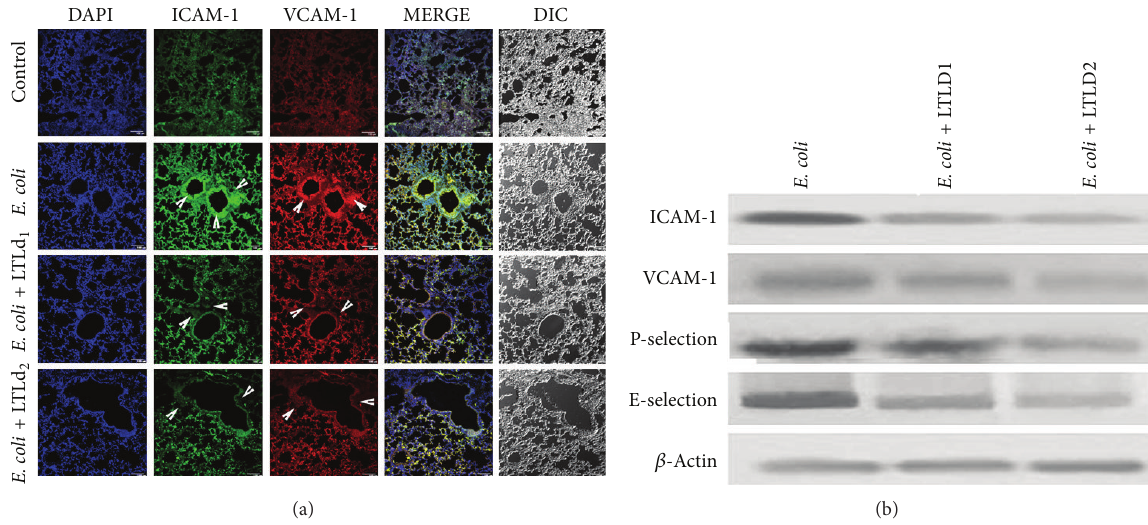
Figure 7: Effect of LTL in cellular localization of (a) intercellular adhesion molecule-1 (ICAM-1, green) and vascular cell adhesion molecule-1 (VACM-1, red); arrow indicates localization of cell adhesion molecule evaluated by laser scanning confocal microscope in 100x magnification. (b) Western blot protein level expression of cell adhesion; ICAM-1, VCAM-1, P-selectin, and E-selectin were markedly suppressed after E. coli O18:K1, 10 4 CFU challenge and pretreatment with LTL at doses LTLD1 (25 mg/kg) and LTLD2 (50 mg/kg) in mice lung.